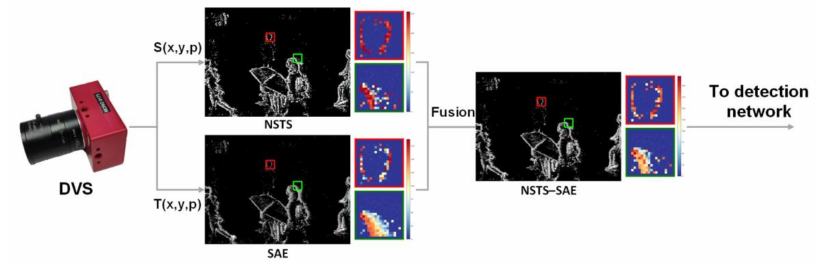
Figure 2. The overview of the event integrator with NSTS–SAE (neighborhood suppression time surface-surface of active events) fusion. Event integrator first encodes the event output in the dynamic vision sensor (DVS) into S ( x , y , p ) with NSTS method as formulated in Algorithm 1. Then, the NSTS result is fused with the intermediate variable T ( x , y , p ) in the encoding process regarded as the SAE